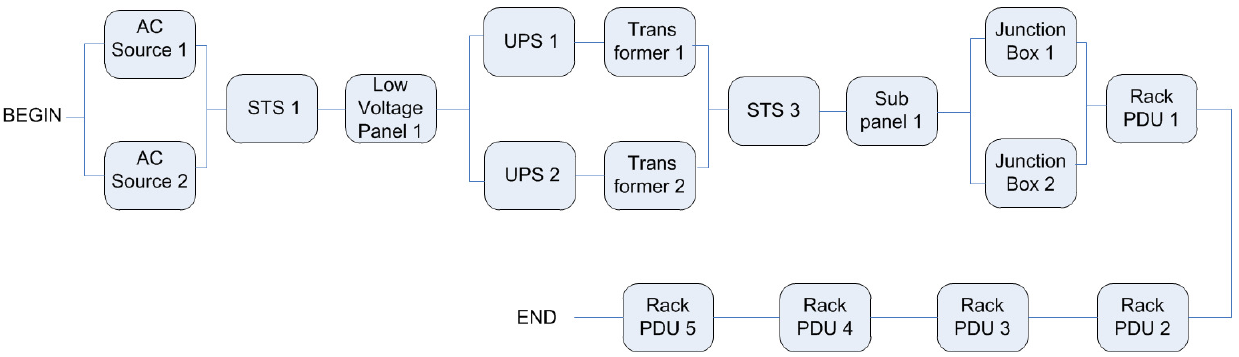
Figure 9. Reliability Block Diagram (RBD) model of architecture A5.